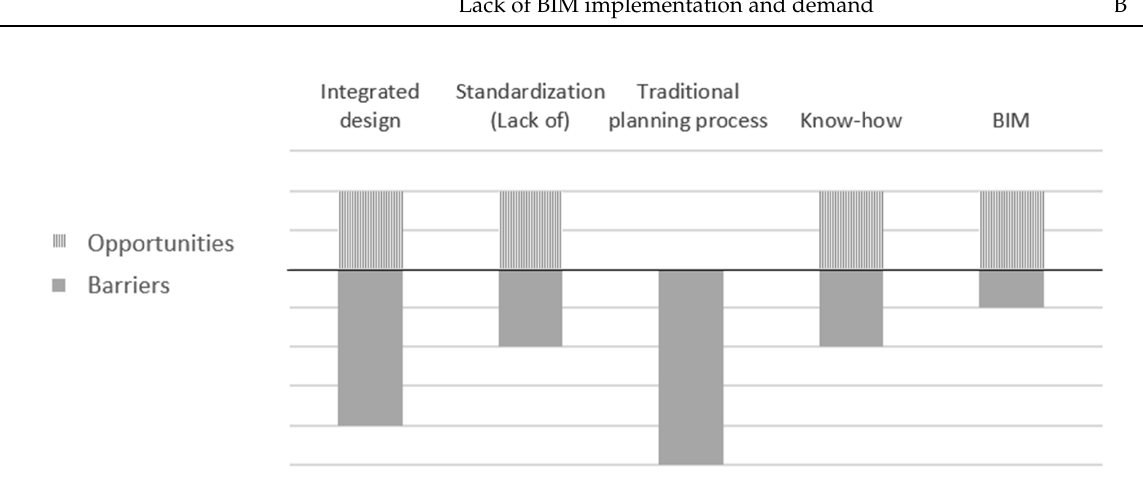
Figure 5. Relation of opportunities and barriers corresponding to the sub-codes allocated in each code of the category Design .